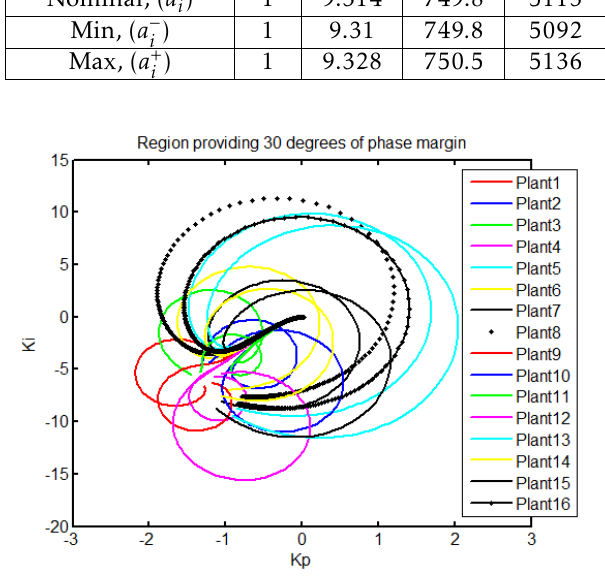
Figure 7. The region that provides robust stability with atleast 30 0 phase marin within the acceptable stabilizing region when ± 25 % uncertainty is introduced into the wind turbine model